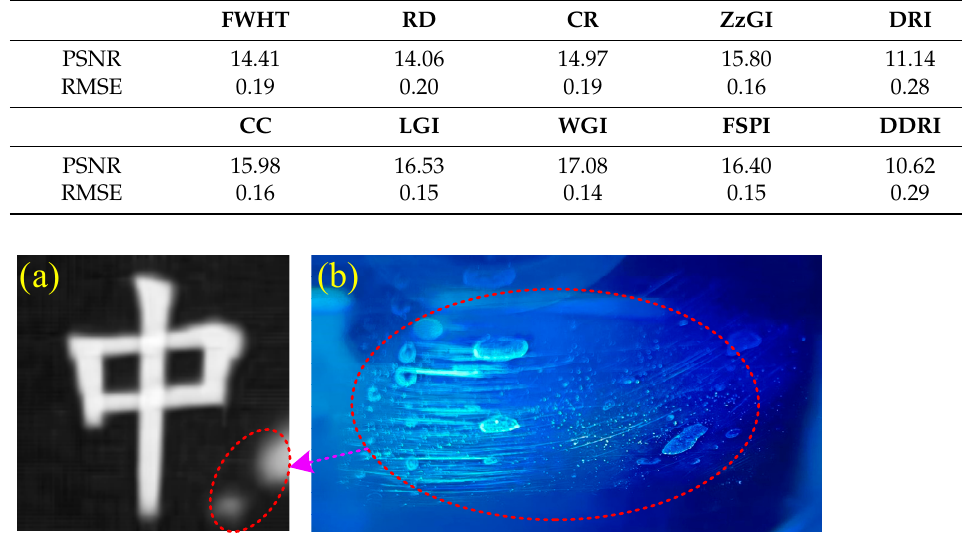
Table 7. PSNR and RMSE of images corresponding to the object “ 中 ” in Figure 10. Figure 11. ( a ) UGI image restored by LGI, and ( b ) side wall image of the WT. The red dotted circles in ( a , b ) denote the possible relationship between the dirt stains and light spots.